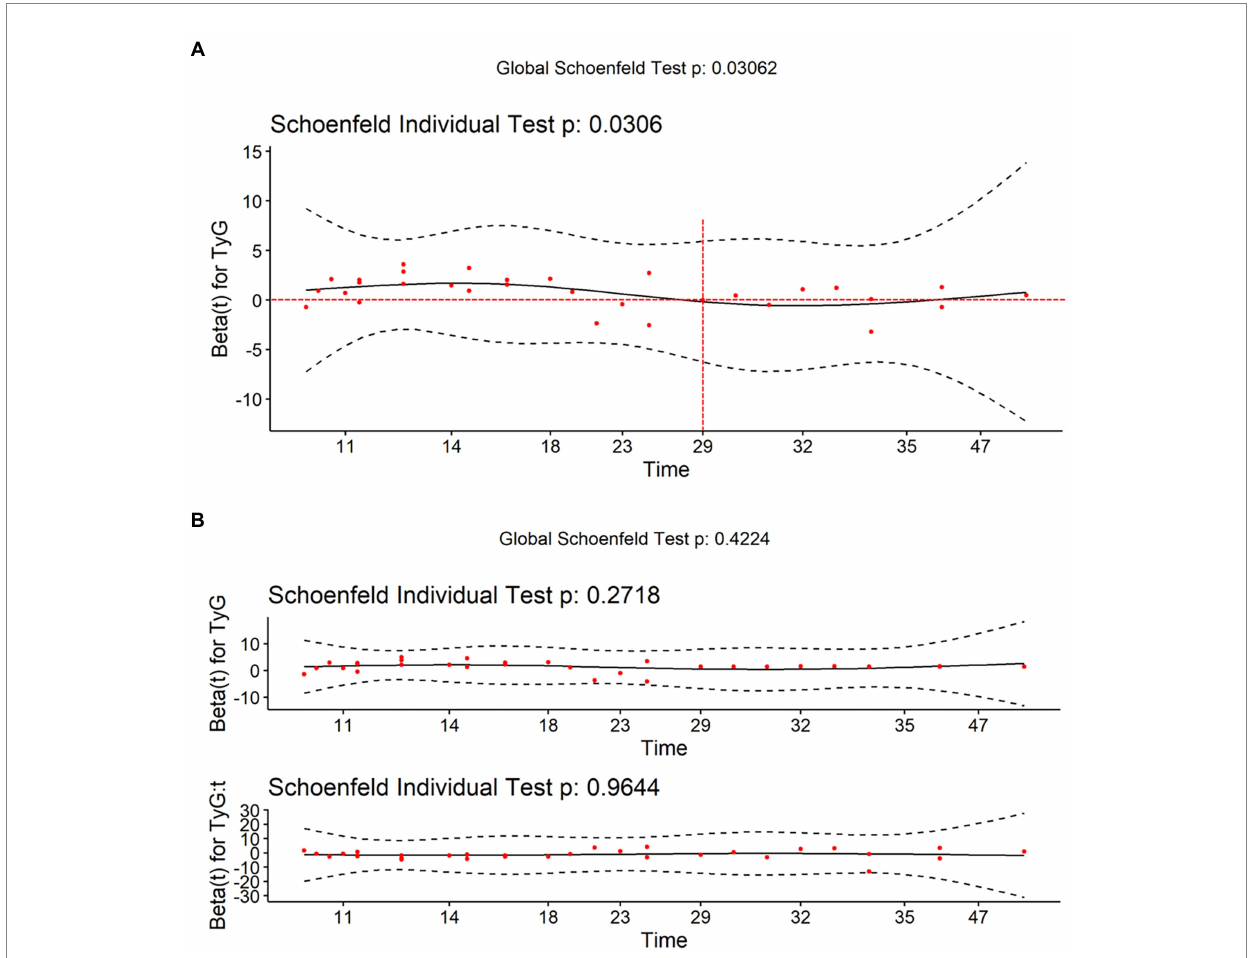
FIGURE 2 Visualization of Schoenfeld residuals. The red points represent the Schoenfeld residuals. The black curve represents the smooth curve of Schoenfeld residuals against time. The black dashed line represents the confidence interval of the smooth curve. The red dashed line represents zero horizontal line. (A) The smooth curve fluctuates up and down the zero horizontal line over time, which does not meet the PH assumption. (B) After adding 29 months as the time interaction term, the smooth curve lies on the zero horizontal line, satisfying the proportional-hazards assumption ( p >